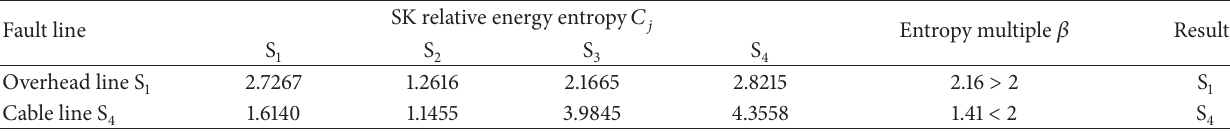
Table 7: SK relative energy entropy with different fault distances ( 𝜃 = 0 ∘ , 𝑅 = 20 Ω ).